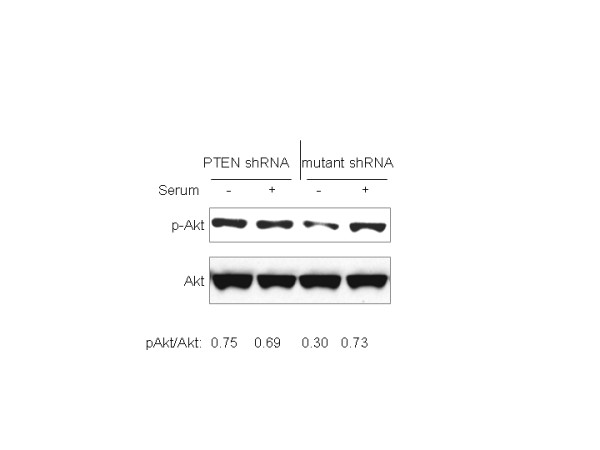
Akt phosphorylation is increased in PTEN-knockdown cells. Subconfluent ACHN cells stably transfected with PTEN or mutant control shRNA were transferred to serum-deficient media (0.5% FBS). After 18 hr, fresh serum-deficient media (0.5% serum, "-") or serum-replete media (10% serum, "+") was added for 30 minutes. Cell lysates were immunoblotted with antibodies against phosphorylated and total Akt. Lysates from 3T3 murine fibroblasts were used as controls. Densitometry of p-Akt is normalized to Akt.